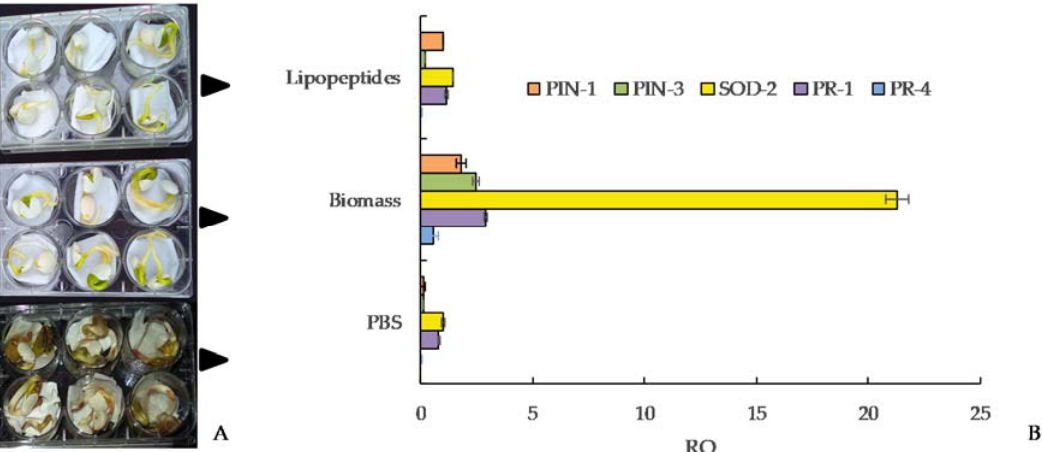
Figure 5. Effect of Bacillus subtilis treatments ( A ) in the expression of the Lupinus mutabilis growth-/ defense-related genes. ( B ) Relative quantity expression (RQ) of PIN-1, PIN-3, SOD-2, PR-1, and PR-4 genes induced by B. subtilis cells, lipopeptide extract, or sterile PBS as control was normalized against actin gene. Source: [59].